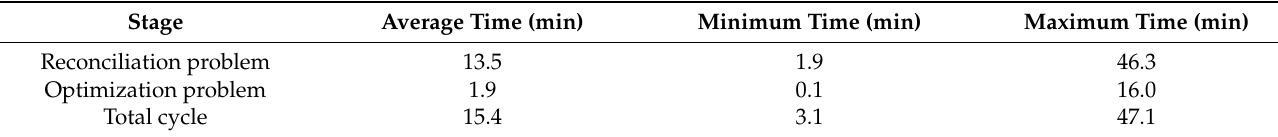
Table 6. Computational cost of each stage of the RTO